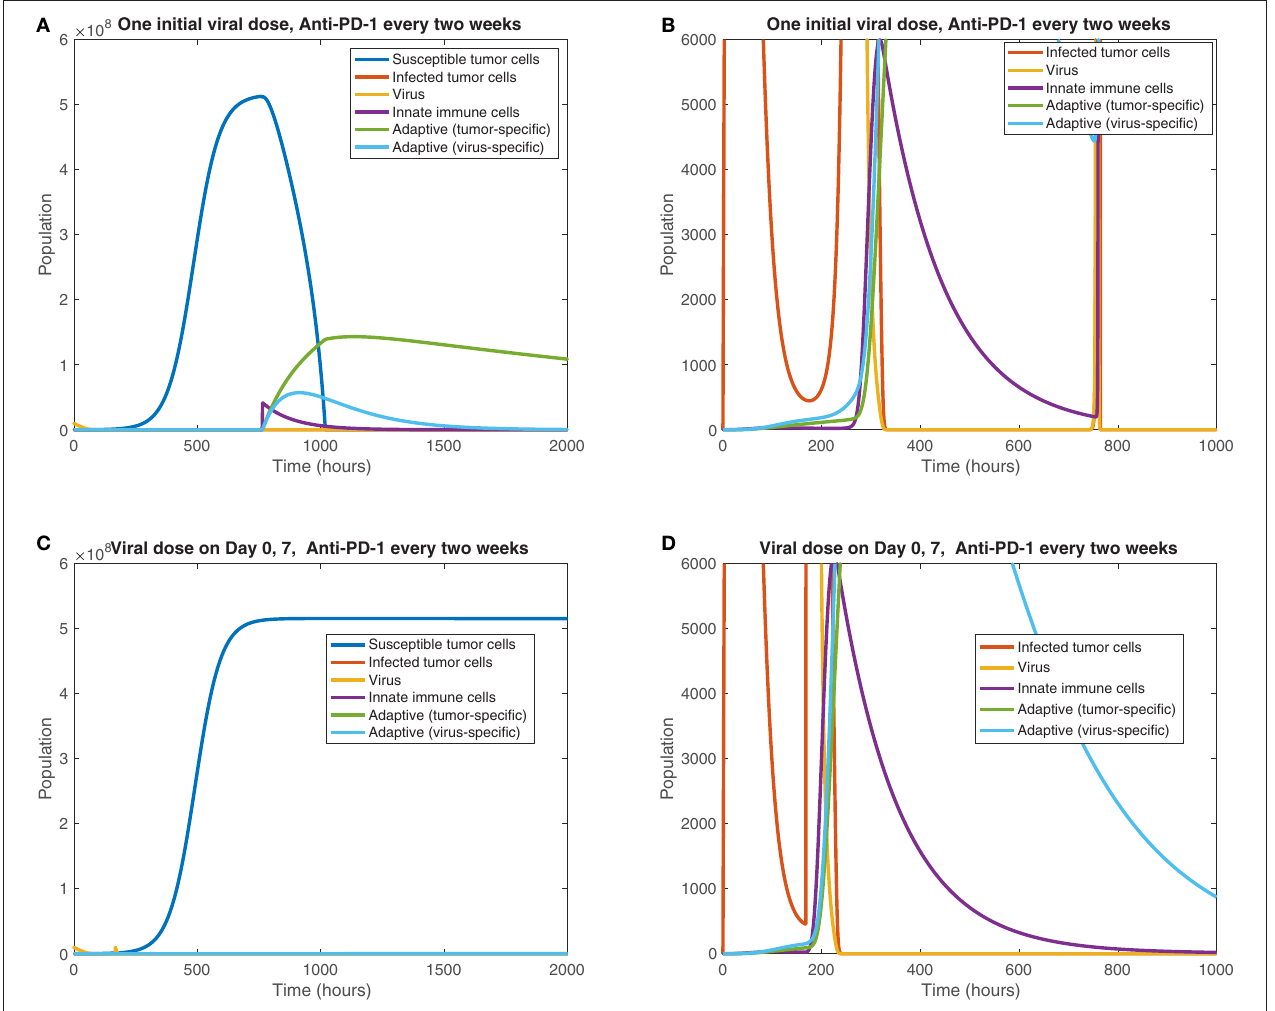
FIGURE 11 | Treatment interference from a second viral dose. We display the cell populations over time in the baseline case, with anti-PD-1 dosing every 2 weeks and one initial viral dose, shown in (A,B) , and with one initial viral dose and a second viral dose at 1 week, shown in (C,D) . The second column, consisting of figures (B,D) , shows a zoomed in version of each of the plots to the